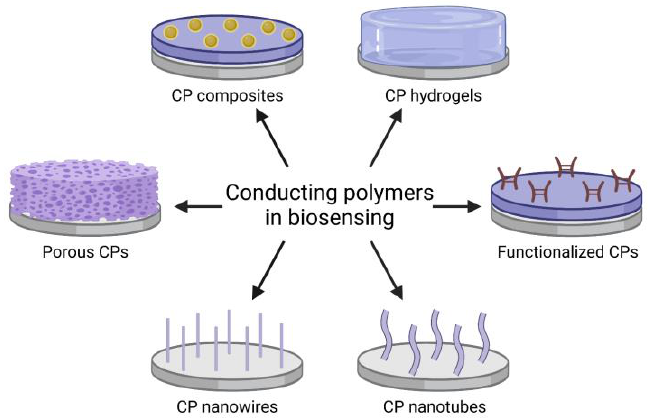
Scheme 3. Different forms of conducting polymers (CPs) used for the design of electrochemical bi- osensors. Created with